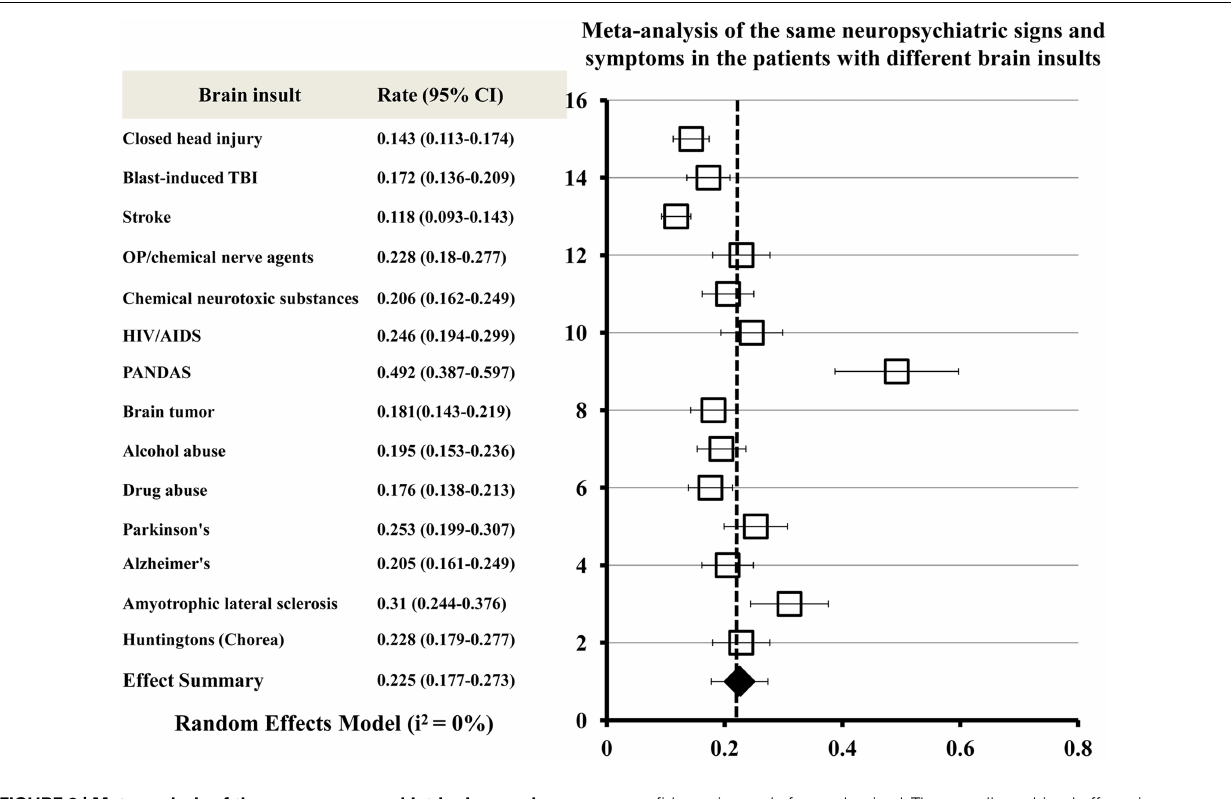
FIGURE 2 | Meta-analysis of the same neuropsychiatric signs and symptoms shared by all acute and chronic brain insults . Forest plots of the meta-analysis show effect size (the rate) and 95%